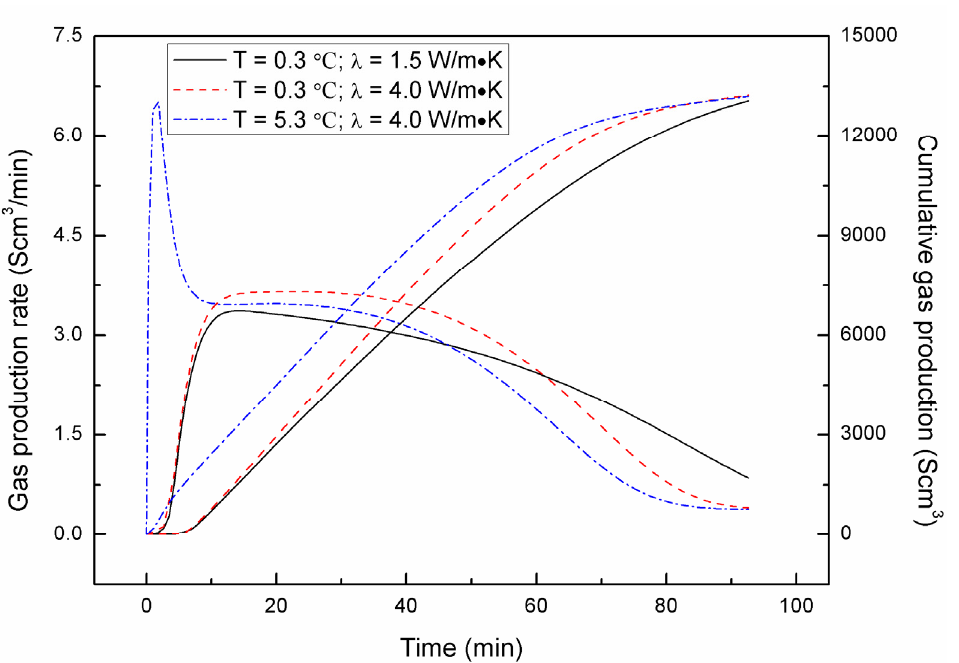
Figure 9. Gas production rate and cumulative gas production time evolution for different temperature and rock thermal conductivity with the same depressurizing